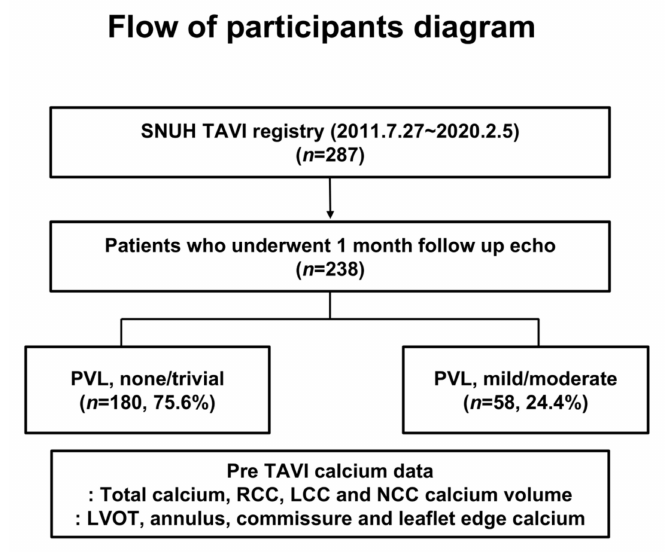
Figure 1. Flow diagram of participants. LCC, left coronary cusp; LVOT, left ventricular outflow tract; NCC, non-coronary cusp; PVL, paravalvular leakage; RCC, right coronary cusp; TAVI, transcatheter aortic valve